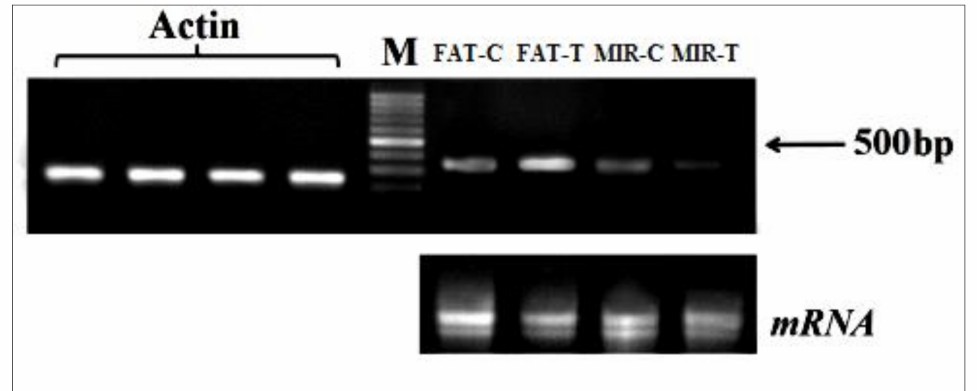
Figure 5. RT-PCR analysis of the expression level of TaHKT1;5 gene in roots of salt-sensitive Fatima (FAT) and salt-tolerant Mirbashir 128 (MIR) genotypes under control (C, control) and 150 mM NaCl stress (T, salt treatment) conditions using specific gene primers. A 250 pb actin gene fragment was amplified by RT-PCR as the internal control. M, Marker, 100 bp DNA ladder. The arrow shows a 500 bp band of DNA ladder. Total RNA samples extracted from control and stressed plant variants are also